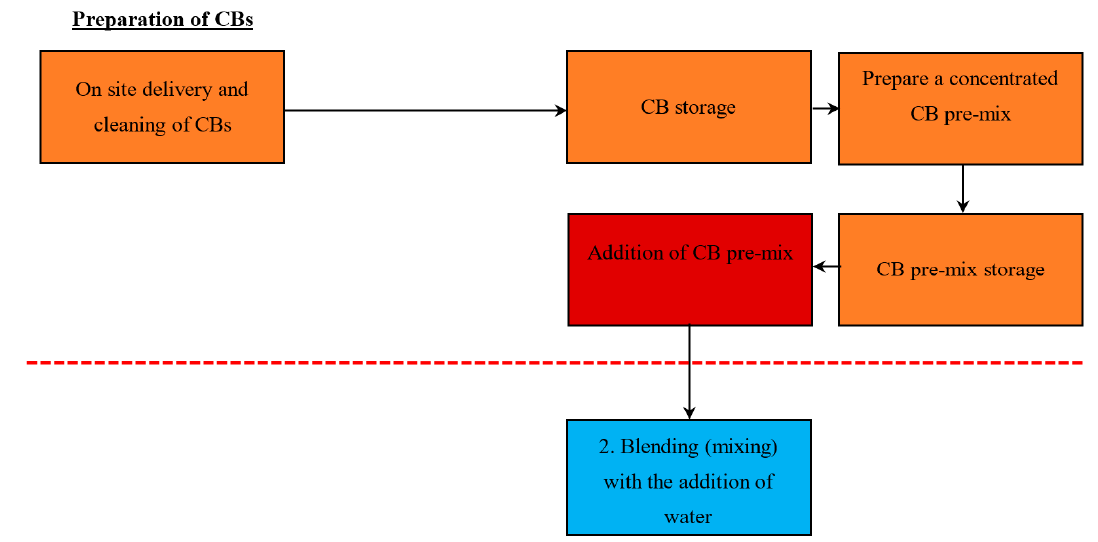
Figure 6. Method 2—Addition of a concentrated CB pre-mix into the Manual Process.